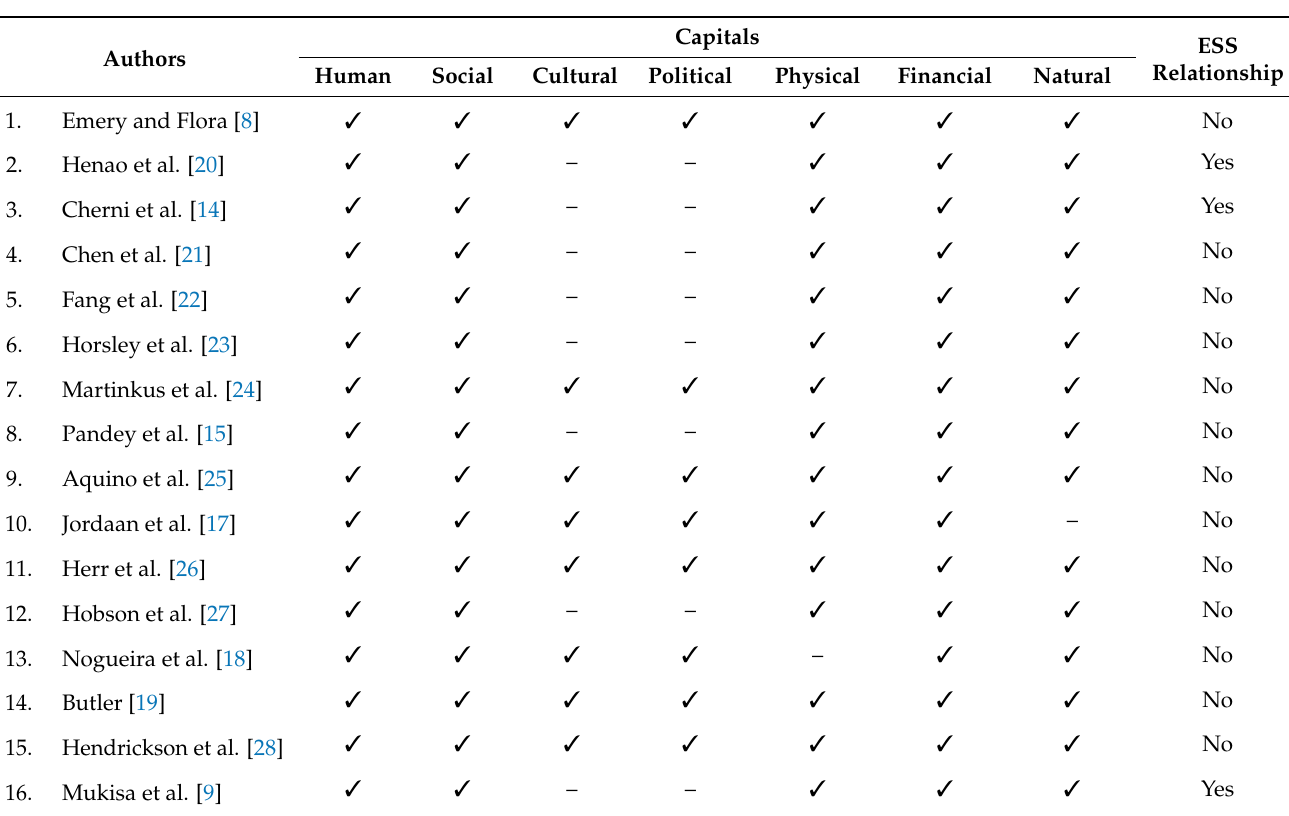
Table 1. Evaluation of methodologies for calculated assets of